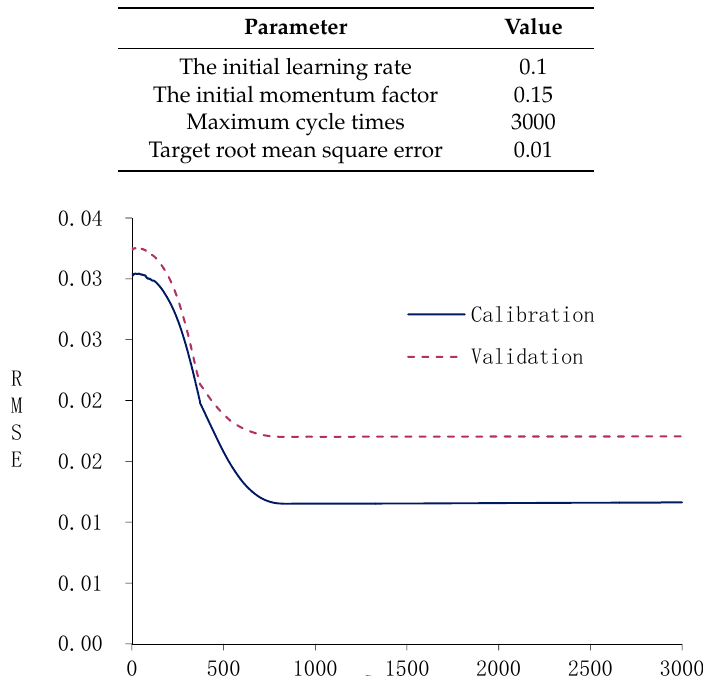
Table 1. BPC parameter setting.